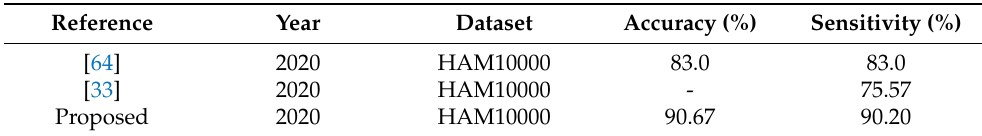
Table 10. Comparison of the proposed method with the existing techniques.